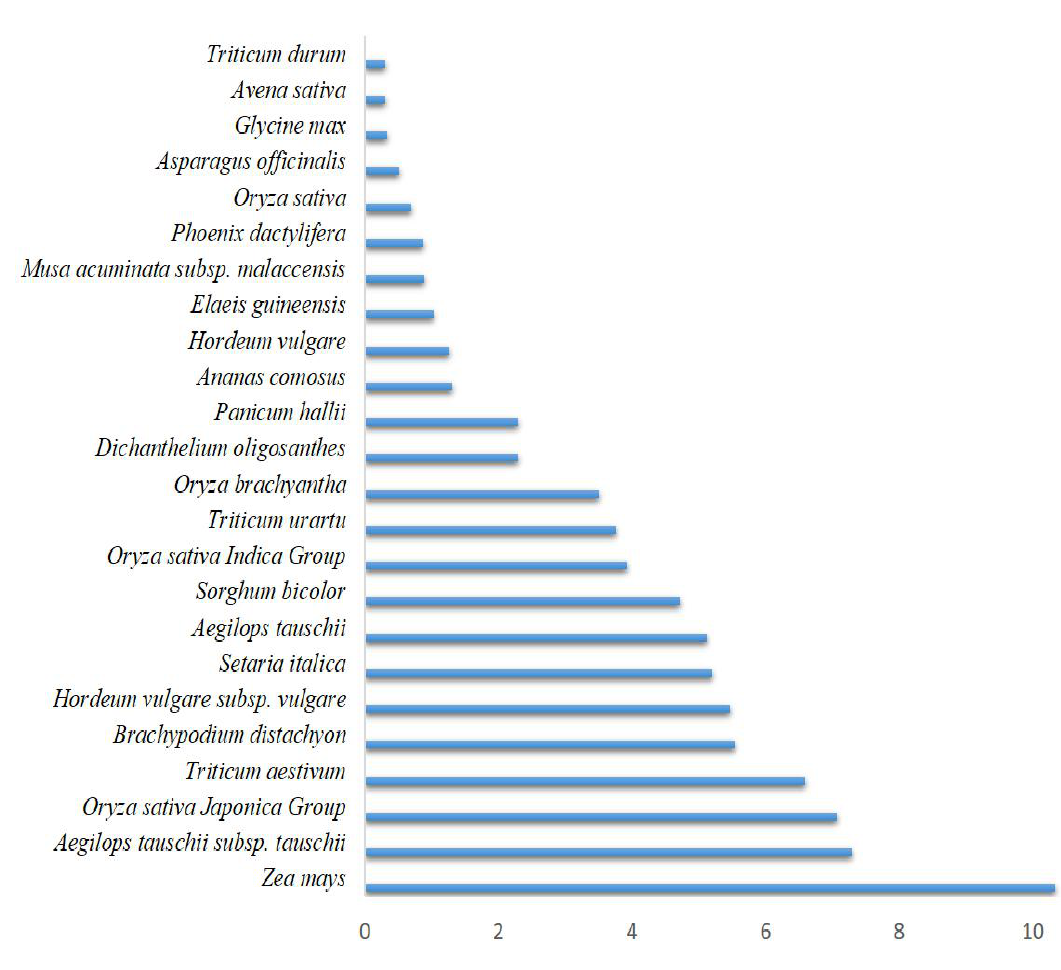
Figure 4. Species distribution of T. aestivum SSR-containing